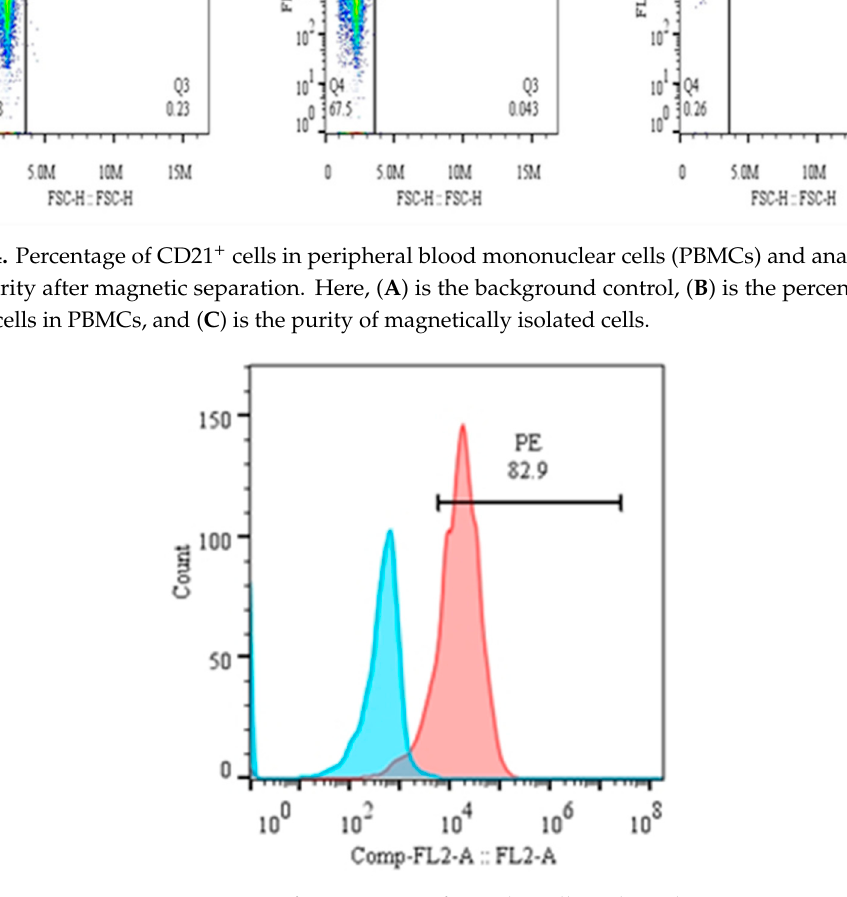
Figure 5. Percentage of CD21 in transformed B cells at the 3rd passage. 3.3. Specificity Analysis of the B Cells Line The percentages of the CD21, IgM and WC4 surface markers in 6th and 10th generation cells (polyclonal cell line) were ~99.0, 6.52–14.2 and 1.3–2.5%, respectively, whereas those of IgM and WC4 in normal isolated pure B cells were 96.6 and 85.9%, respectively. The percentages of CD21 (98.8, 99.7, 98, 98.5, and 97%; mean ± SD of 98.4 ± 1.00), IgM (3.51, 0.64, 1.42, 0.99, and 2.83%; mean ± SD of 1.88 ± 1.23) and WC4 (0.51, 1.96, 0.71, 0.80, and 0.97%; mean ± SD of 0.99 ± 0.57) were determined in the five clones, respectively. Of these, clone 1 was maintained, preserved, and used for the identification of cytokine production (Figure 6).